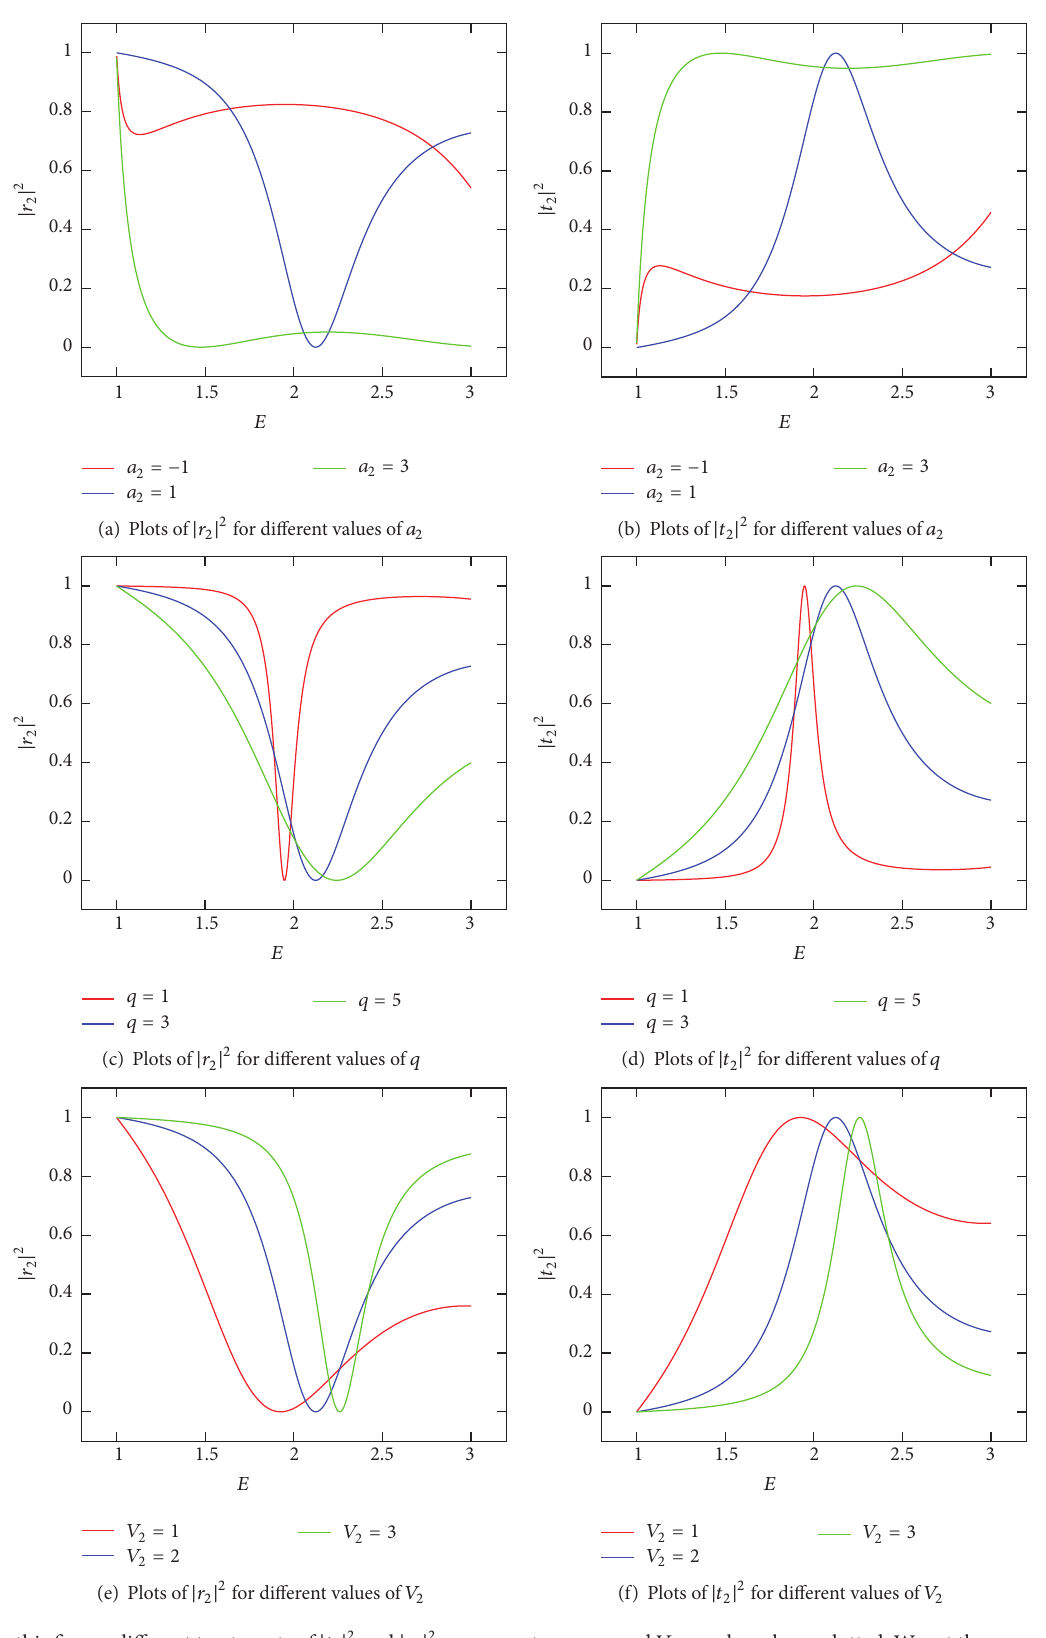
(e) Plots of |𝑟 2 | 2 for different values of 𝑉 2 (f) Plots of |𝑡 2 | 2 for different values of 𝑉 2 Figure 4: In this figure, different treatments of |𝑡 2 | 2 and |𝑟 2 | 2 as parameters 𝑎 2 ,𝑞 , and 𝑉 2 vary have been plotted. We set the parameters in (a) and (b) 𝑉 2 = 2 , 𝑞 = 3 , (c) and (d) 𝑉 2 = 2 , 𝑎 2 = 1 , and (e) and (f) 𝑞 = 3 , 𝑎 2 = 1